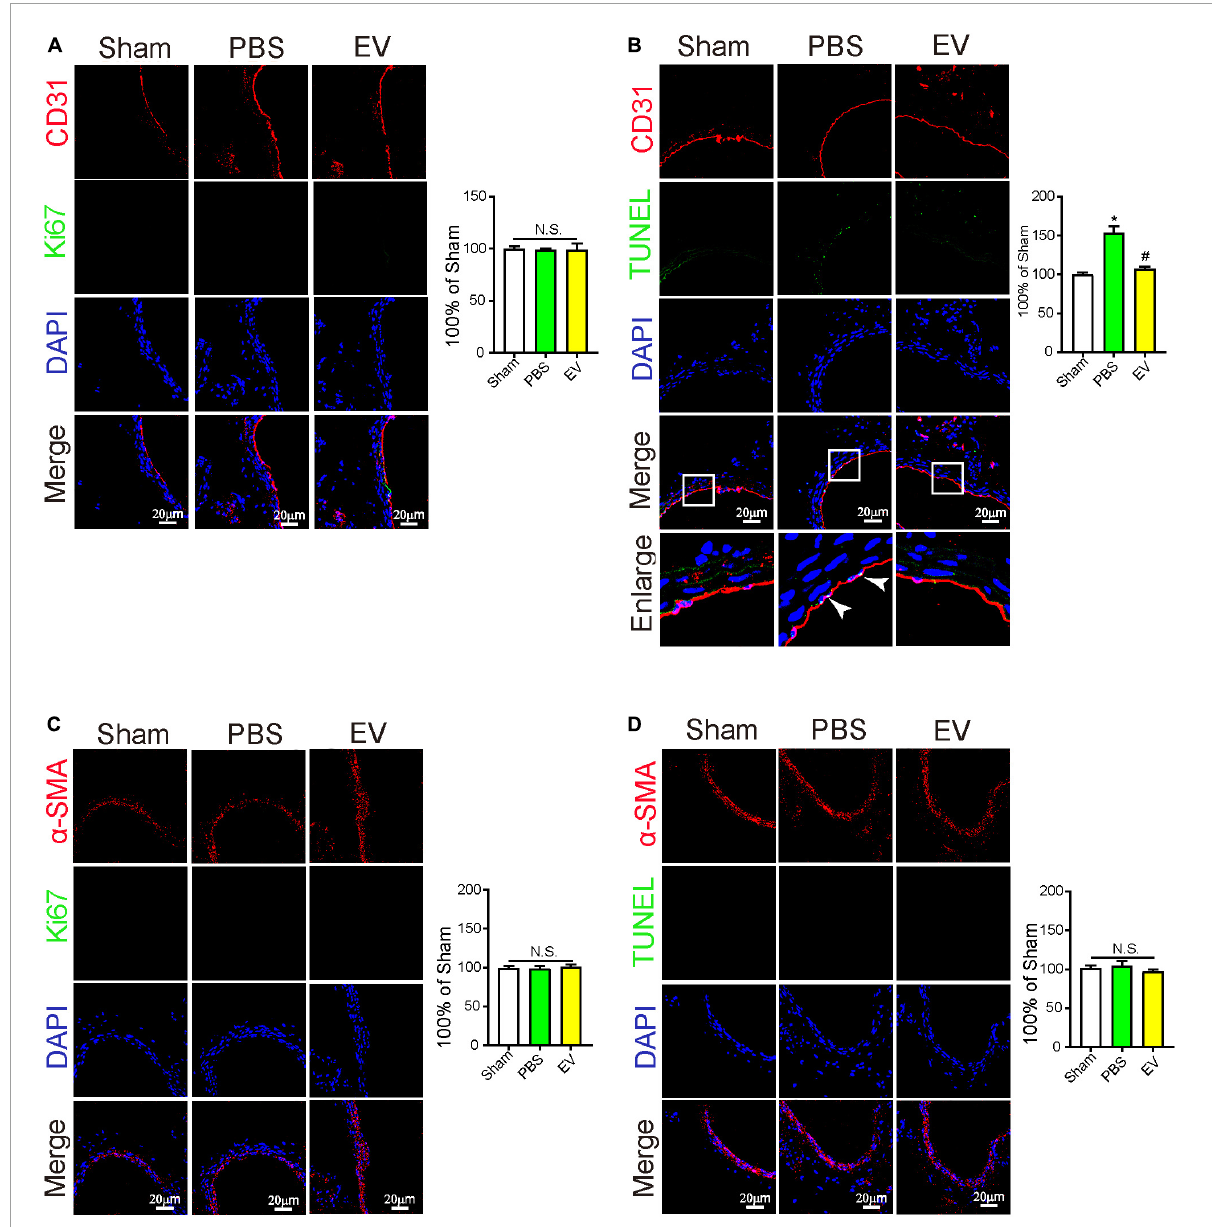
FIGURE4 The protective effect of human-induced pluripotent stem cell- endothelial cell-extracellular vesicle (hiPSC-EC-EV) on carotid artery through inhibition of EC apoptosis. (A–D) Representative immunostaining images stained for CD31 (Red) and Ki67 (Green) in panel (A) , stained for CD31 (Red) and TUNEL (Green) in panel (B) , stained for α -SMA (Red) and Ki67 (Green) in panel (C) , and stained for α -SMA (Red) and TUNEL (Green) in panel (D) in the carotid arteries 21 days after the surgery. Data represent mean ± SD from three independent experiments ( n = 3). Differences between linked groups were evaluated by two-tailed Student’s t -test. * p < 0.05 vs. Sham; # p < 0.05 vs.